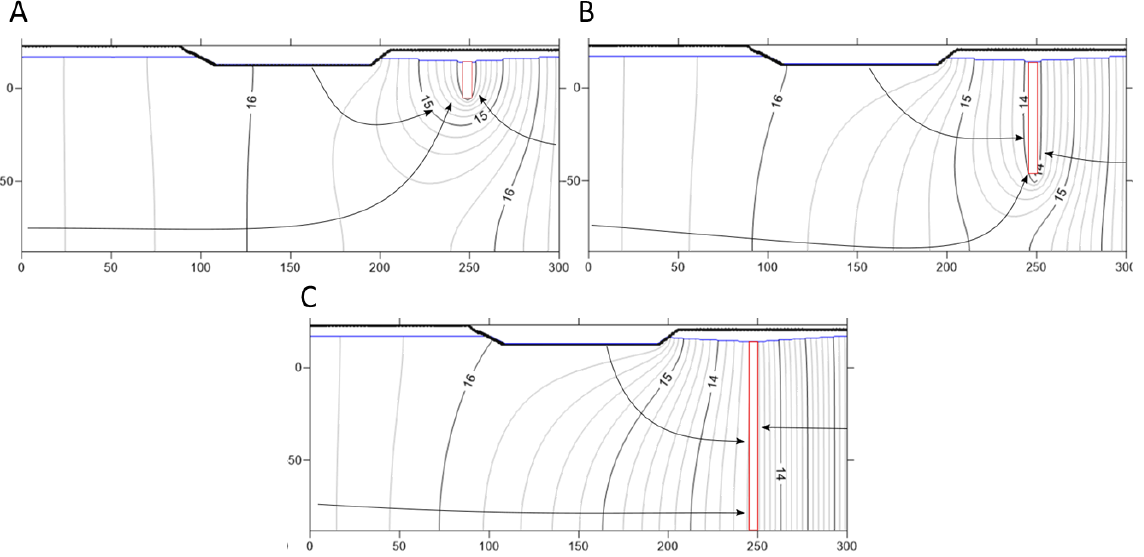
Figure 7. Effect of partially penetrating wells. ( A ) Wells of 25 m, ( B ) Wells of 75 m, ( C ) the fully penetrating wells. All simulations were made in condition H0 for Q = 0.01. Table 4. Flow proportion reaching the pumping wells at Ar = 0.5 with the head gradient H0 for different well penetration ratios and the same flow per well length unit.